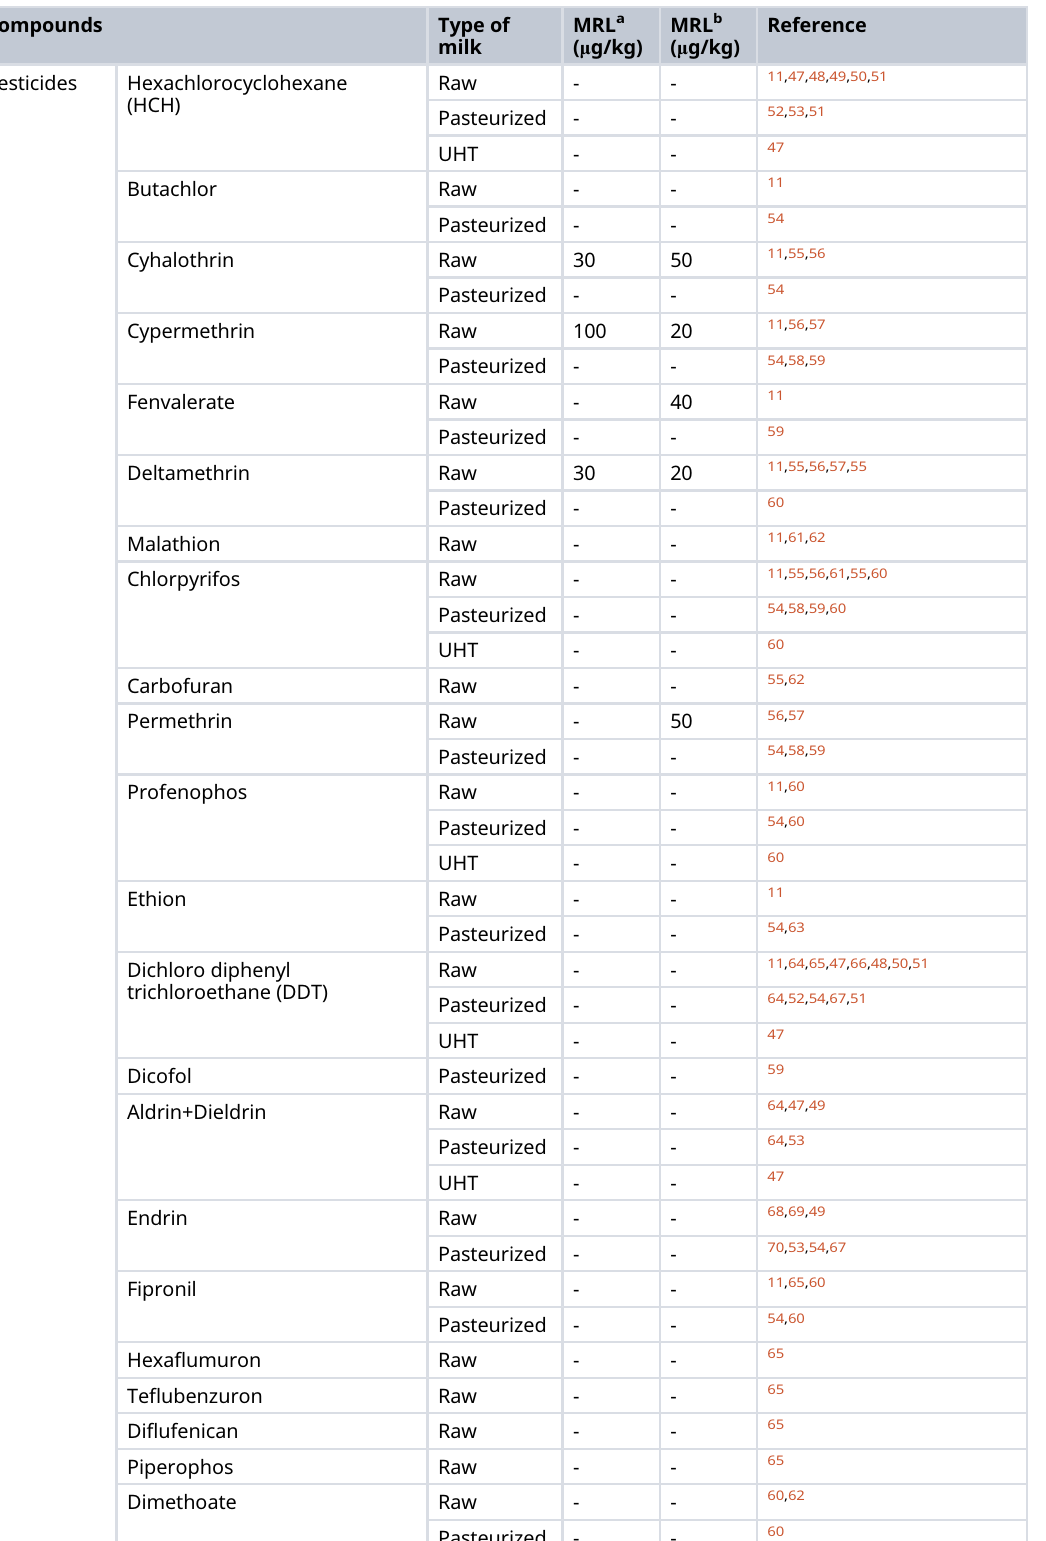
Table 2. Chemical contaminants in bovine milk reported in literature.